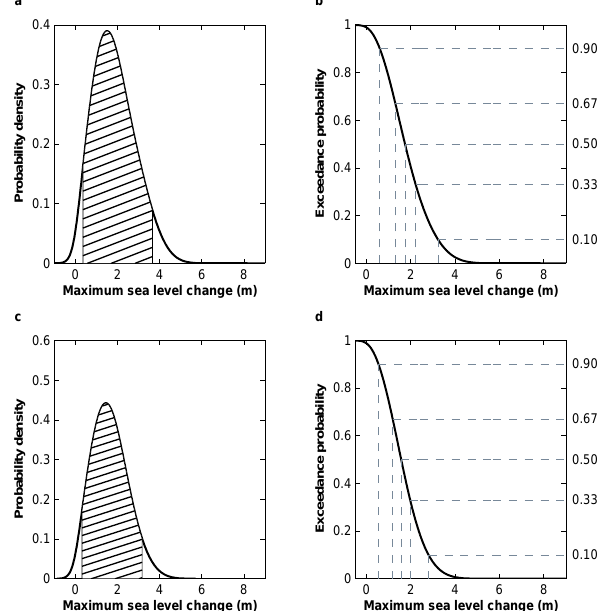
Fig. 10. A probabilistic assessment of the GrIS maximum contri- bution to sea level change during the LIG without the NEEM ice core location constraint (a–b) and assuming ice is present through- out the LIG at the NEEM ice core (c–d) . (a) Probability density plot. The hashed region denotes the 90% confidence interval (0.3 to 3.6m). (b) Exceedance values for the probability distribution. (c) Probability density plot when the NEEM ice core data is included (90% confidence interval: 0.3 to 3.2m). (d) Exceedance values for the probability distribution with the NEEM ice core data included. When the NEEM ice core data is included there is a 90% prob- ability of a GrIS contribution exceeding 0.6m during the LIG, a 67% probability of exceeding 1.2m, a 50% probability of exceed- ing 1.6m, a 33% probability the contribution exceeded 2.0m and a 10% probability it exceeded